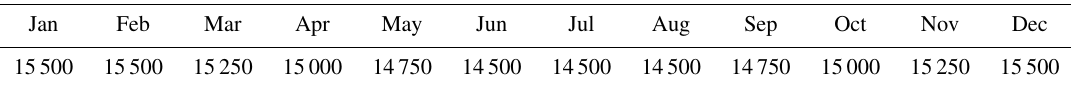
Table 2. Midmonthly (cid:56) threshold values in square meters per second squared to compute the (cid:56) component of high-pressure areas at 850hPa, as described in Sect. 2.4.